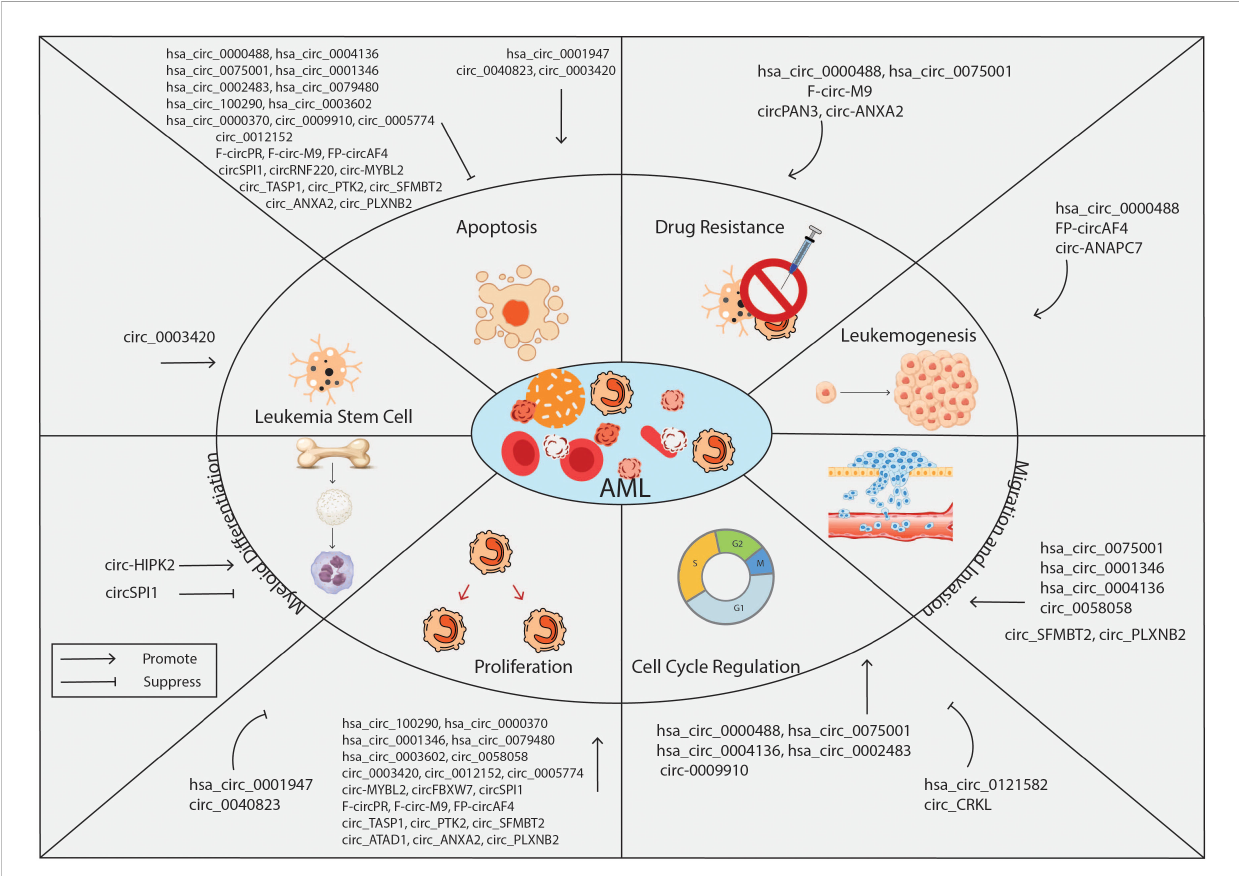
FIGURE 2 Overview of the biological roles of circRNAs in AML. CircRNAs are known to function either as oncogenes or tumor suppressor genes, regulating key cell processes of leukemia cells such as proliferation, apoptosis, cell cycle, stemness, drug resistance, migration, and invasion. CircRNA, circular RNA; AML, acute myeloid